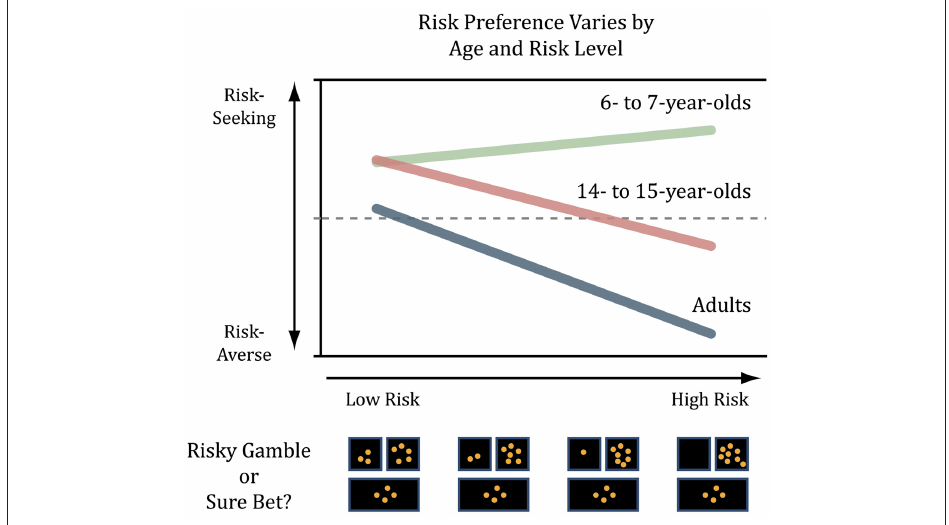
Figure 1 | Children, adolescents, and adults, were presented with the choice between accepting risky gambles at varying levels of risk and taking a sure bet. The figure shown here illustrates that risk-seeking declined with age, and was modulated by level of risk. With increasing risk, children were risk-seeking, while adults and adolescents were